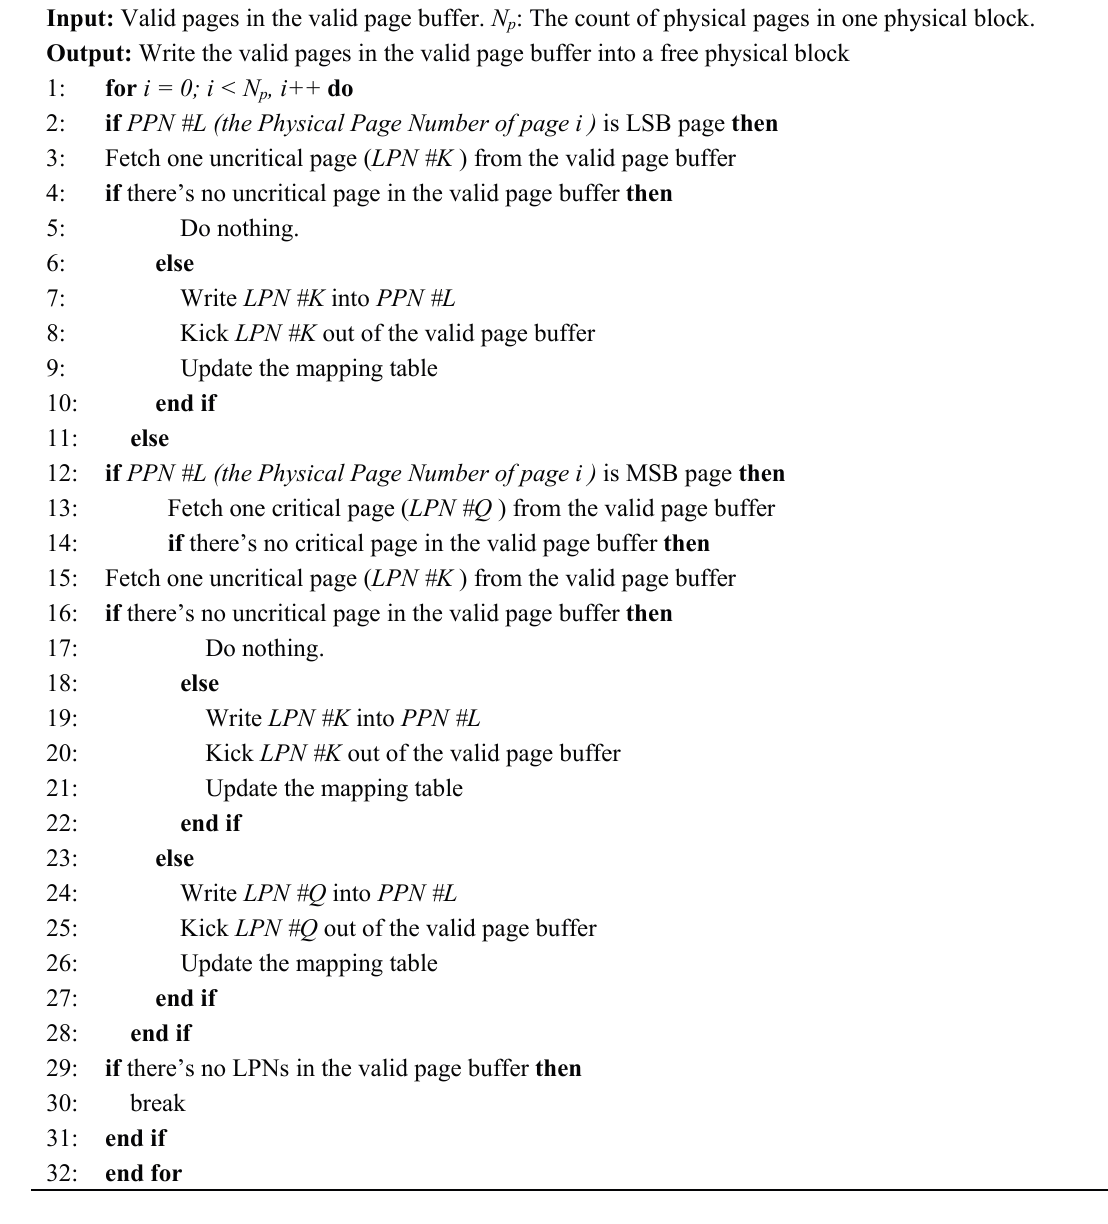
Algorithm 2. Valid page copies in garbage collection for Asymmetric